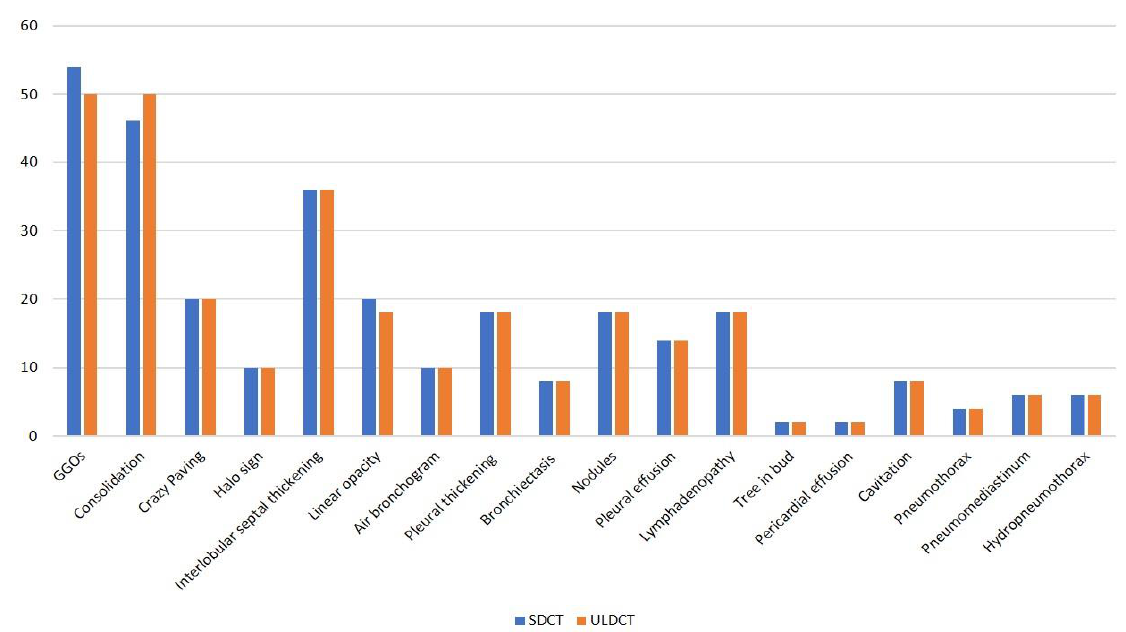
Figure 2. Bar diagram showing various imaging patterns of COVID-19 pneumonia and its frequency